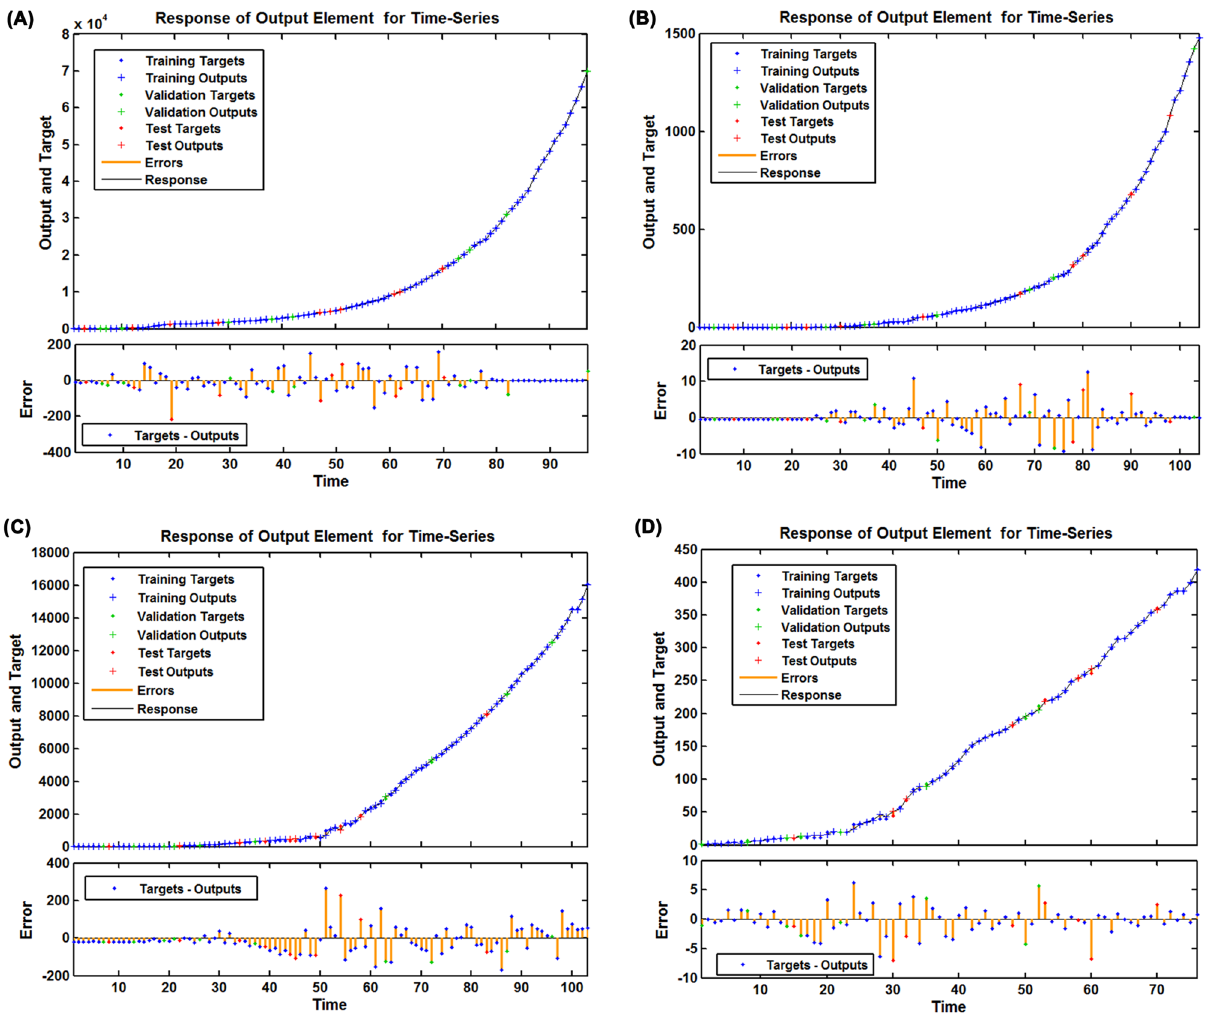
Figure 5. Time series displaying the response results between inputs and outputs. ( A ) Response plot between inputs and outputs for the prevalence dada in South Africa; ( B ) Response plot between inputs and outputs for the mortality dada in South Africa; ( C ) Response plot between inputs and outputs for the prevalence dada in Nigeria; ( D ) Response plot between inputs and outputs for the mortality dada in Nigeria. These plots display which samples were treated as the training, validation and testing datasets, and illustrate the corresponding errors between inputs and targets. It could be seen that the vast majority of data points had smaller errors between inputs and targets, indicating that the identified NARANN methods seem to be adequate for estimating the epidemiological trends of COVID-19 in the study